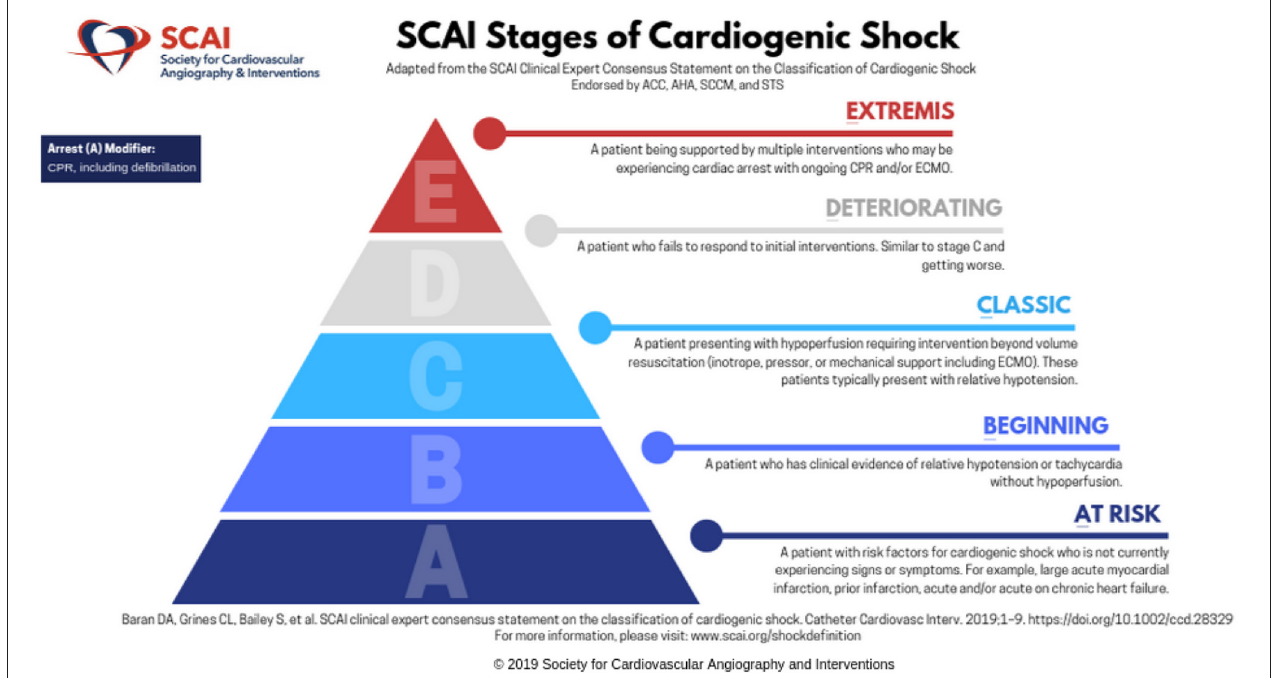
FIGURE 1 | The SCAI Shock classification system. Reprinted by permission from Society for Cardiovascular Angiography and Interventions. © 2021 Society for Cardiovascular Angiography and Interventions (SCAI). All rights reserved